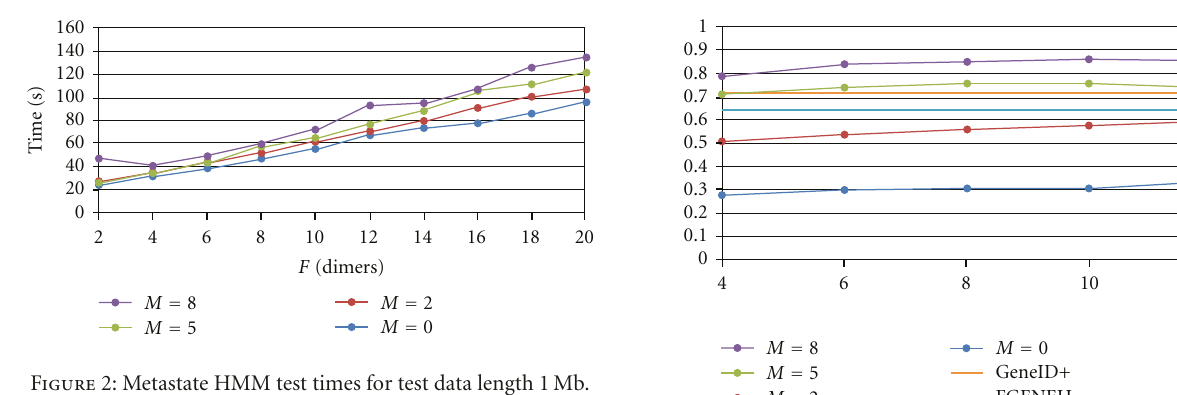
Figure 2: Metastate HMM test times for test data length 1Mb.